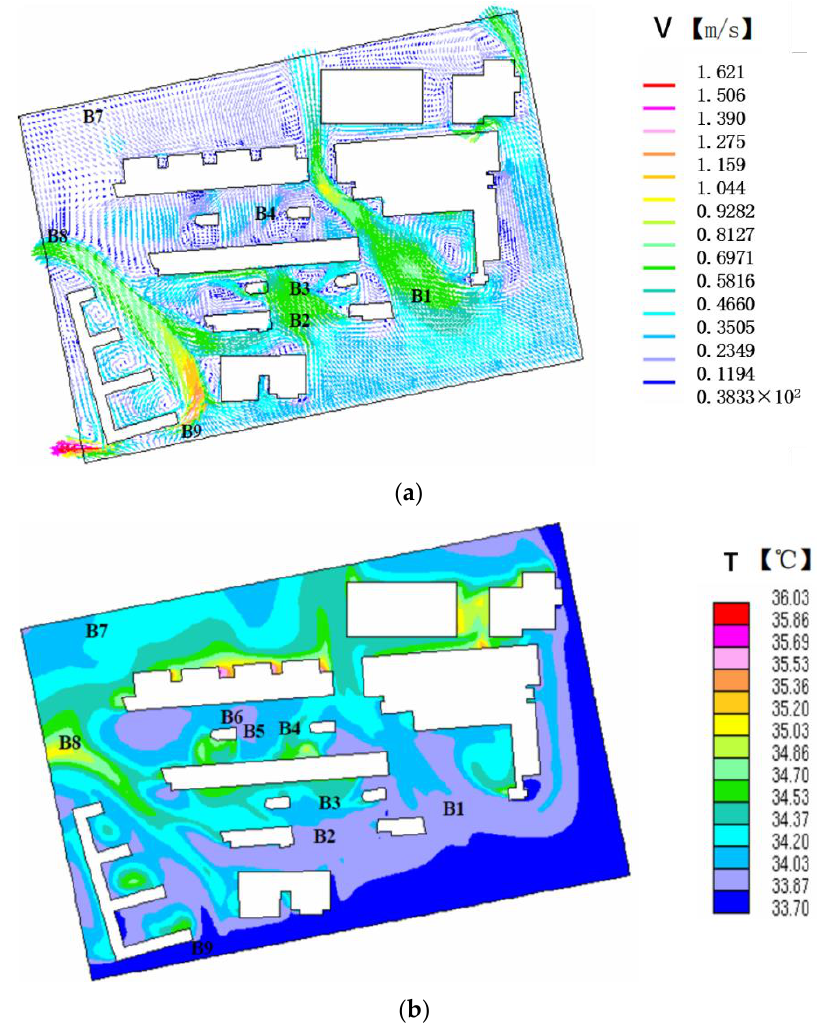
Figure 3. Measuring points and the analytical region. ( a ) The distribution of measuring points dur- ing the actual measurement. ( b ) The analytical region in the simulation.